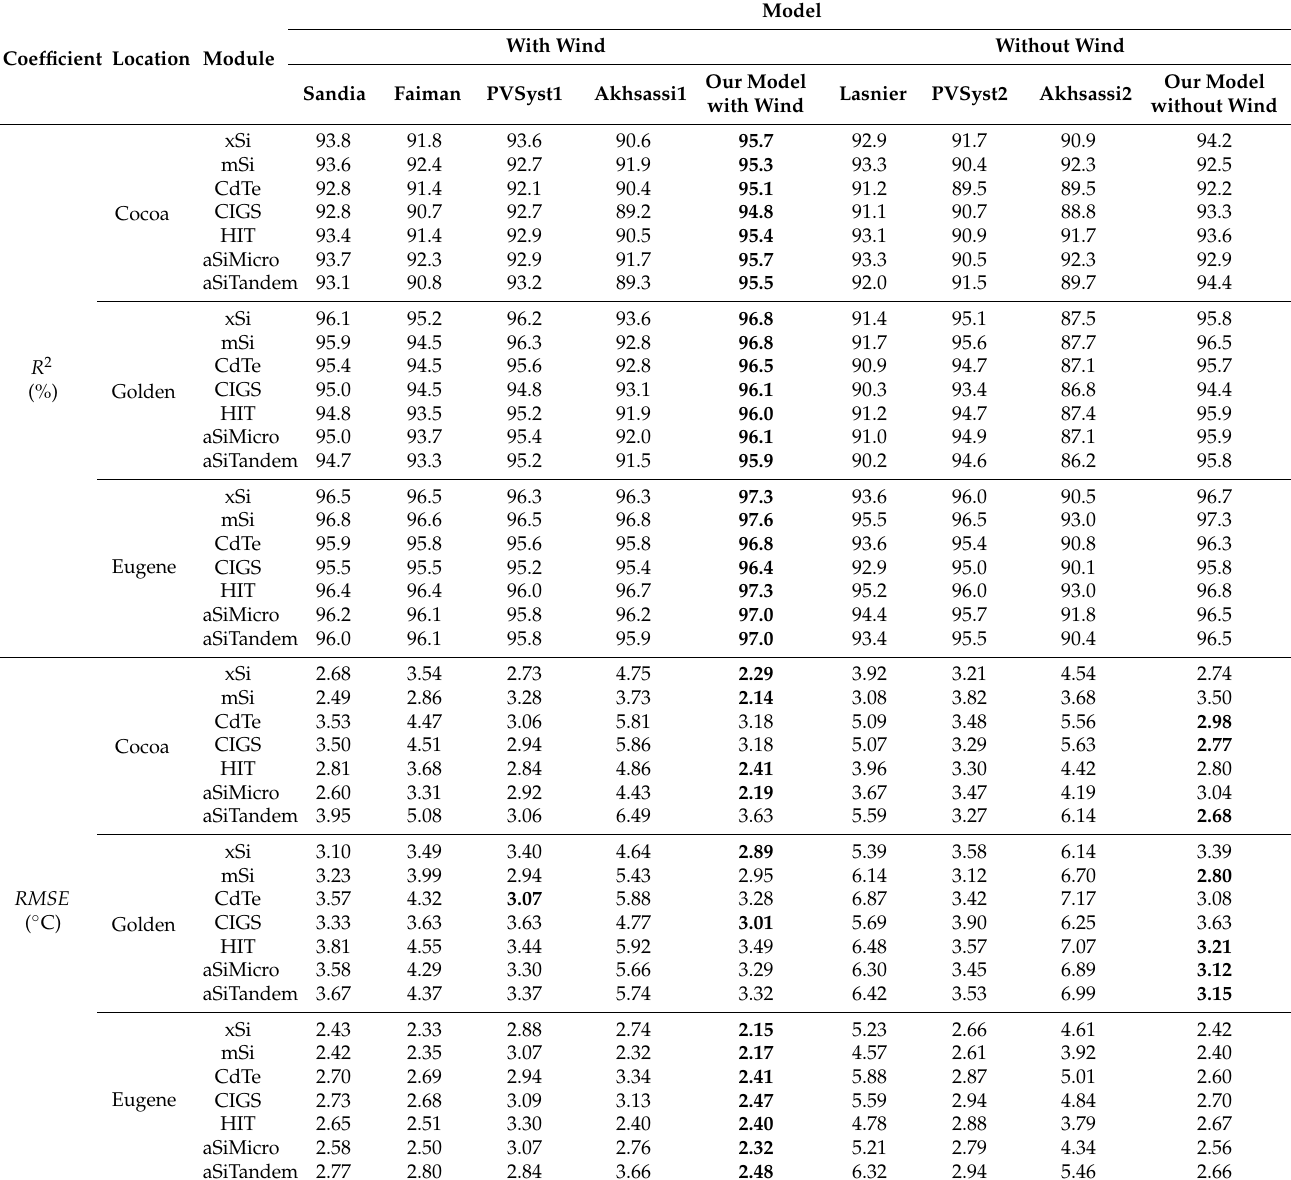
Table A2. The statistical coefficients ( R 2 and RMSE ) for all models with and without wind speed vs. experimental measurement of module back-surface temperature calculated for different